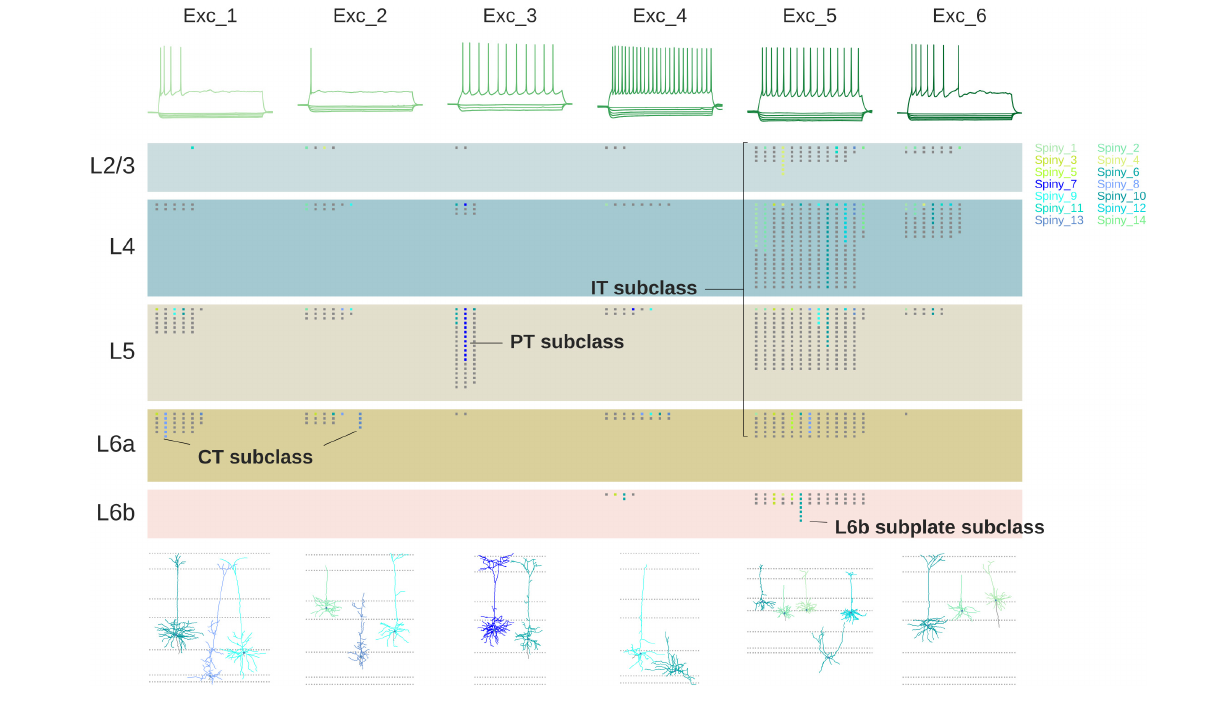
FIGURE 7 | Relations between firing patterns, laminar localization, connectivity and morphology of pyramidal cells. Types of firing patterns at top are aligned with representative cell morphologies giving the patterns at bottom. Laminar localization is shown (each dot a recorded cell) in the middle separated into IT, PT and CT categories; colors indicate the reconstructed cells at bottom [Adapted from Gouwens et al., 2018].